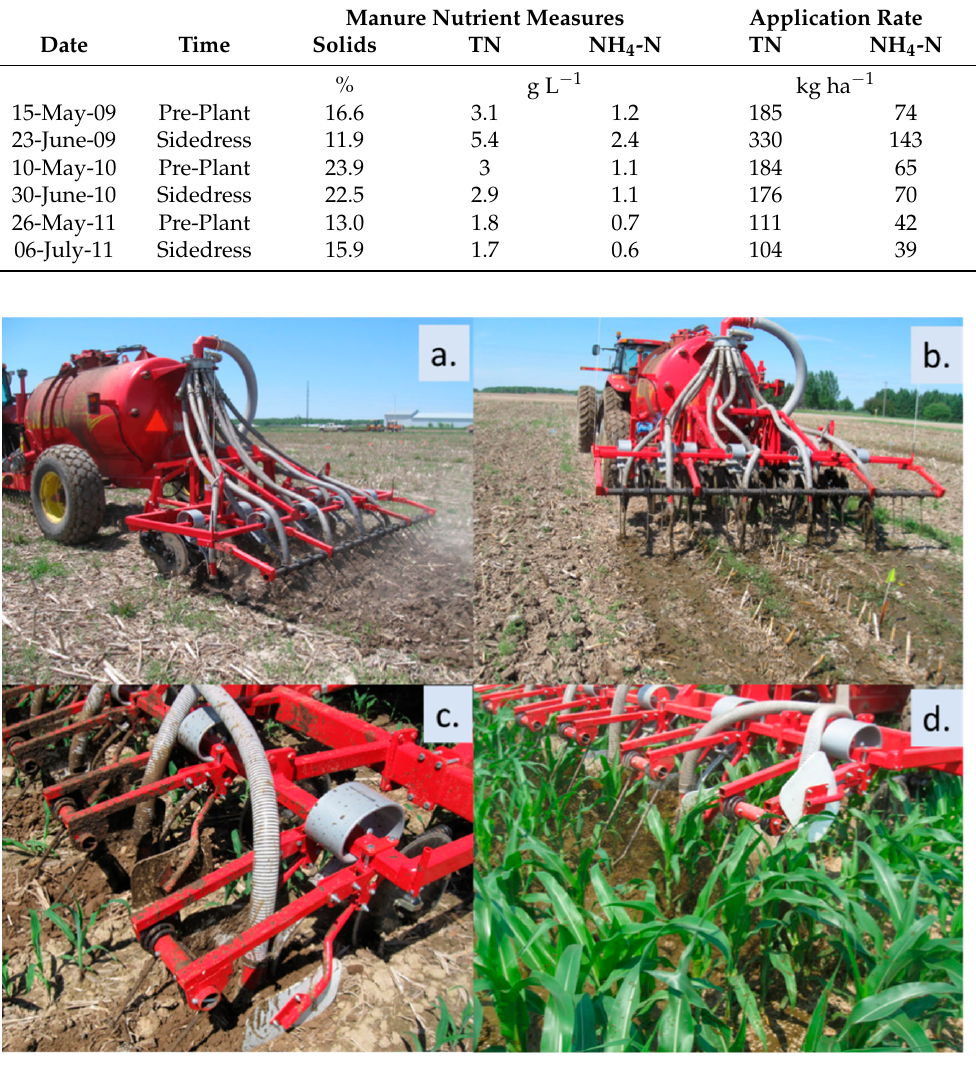
Figure 1. Digital photographs of manure injection implements: ( a ) PP-Inject; ( b ) PP-1-hr and PP-3-day application; ( c ) SD-Inject; ( d ) SD-Surf.